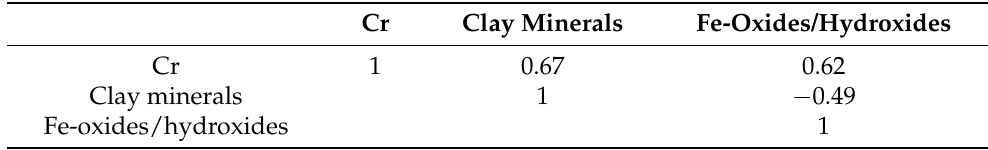
Table 3. Pearson correlation coefficients of Cr, clay minerals and Fe-oxides/hydroxides in soil (The numbers in bold are significant at the p < 0.01